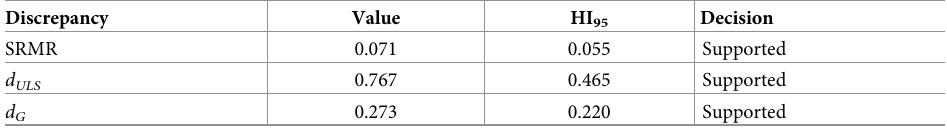
Table 6. Overall saturated model fit evaluation.